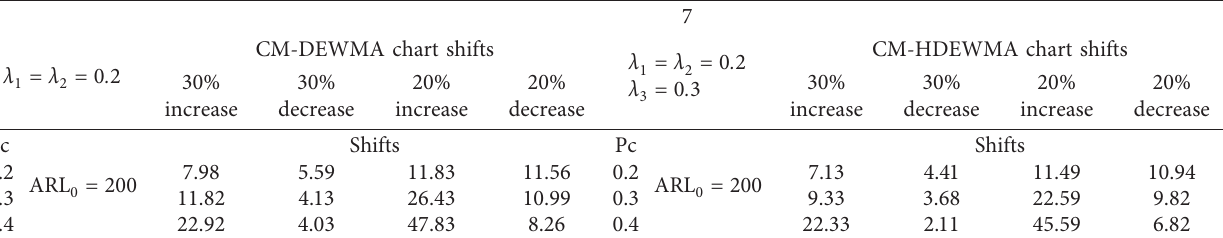
Table 6: Out-of-control ARL values for CM-HDEWMA and CM-DEWMA control charts for n � 3 with MLE α ⌢ � 0 . 91 , β � 0 . 75. n 7 � λ � 0 . 2 λ 1 2